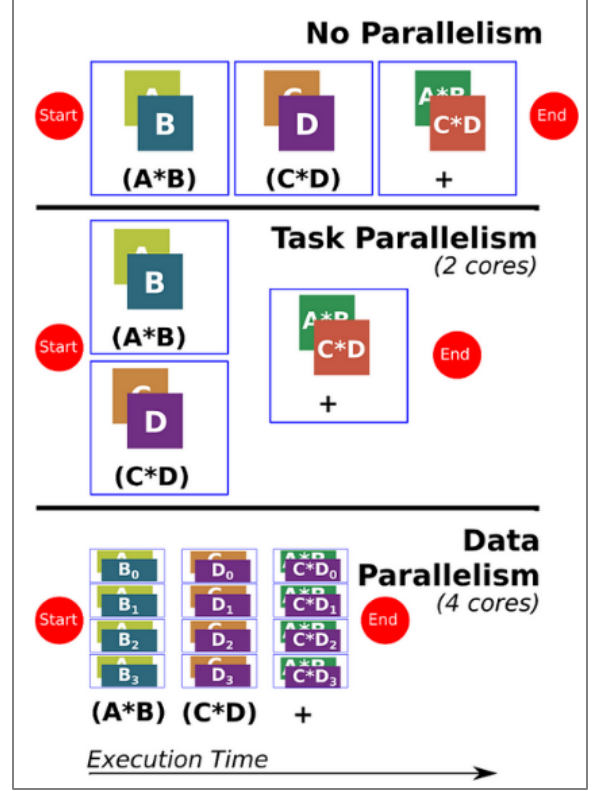
Figure 3 . Parallelism in geospatial application: Task parallelism and data parallelism (Source: